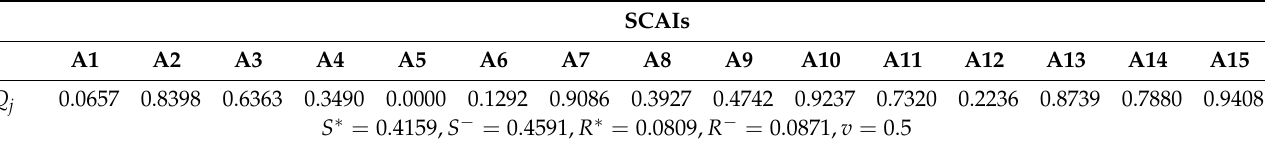
Table 13. Calculation results of benefit ratio Q j .